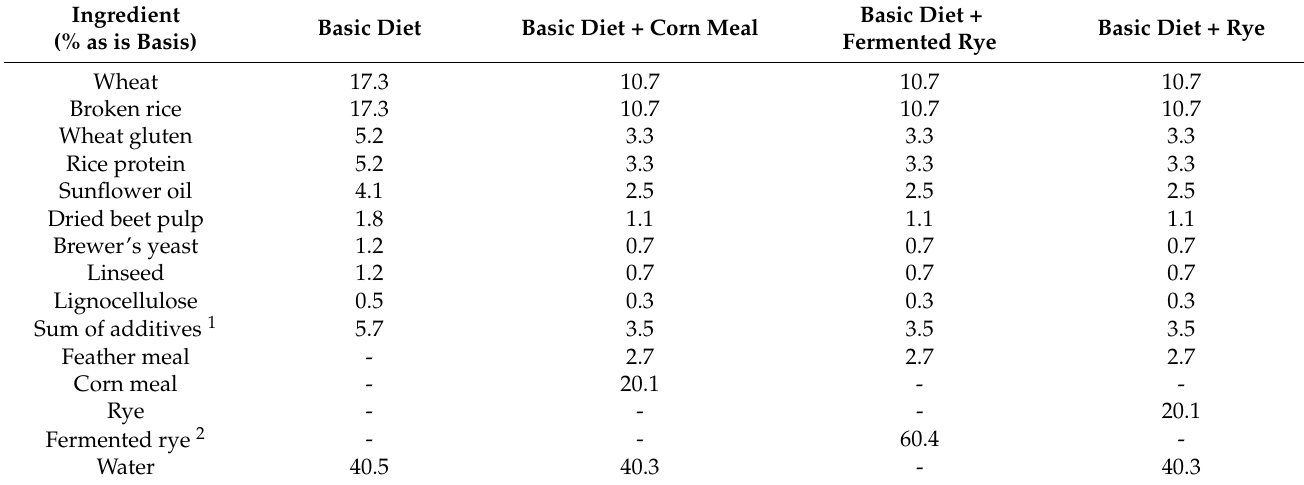
Table 1. Components of the vegetarian diet (basic diet) and the experimental diets supplemented with feather meal as well as either corn meal, fermented rye or